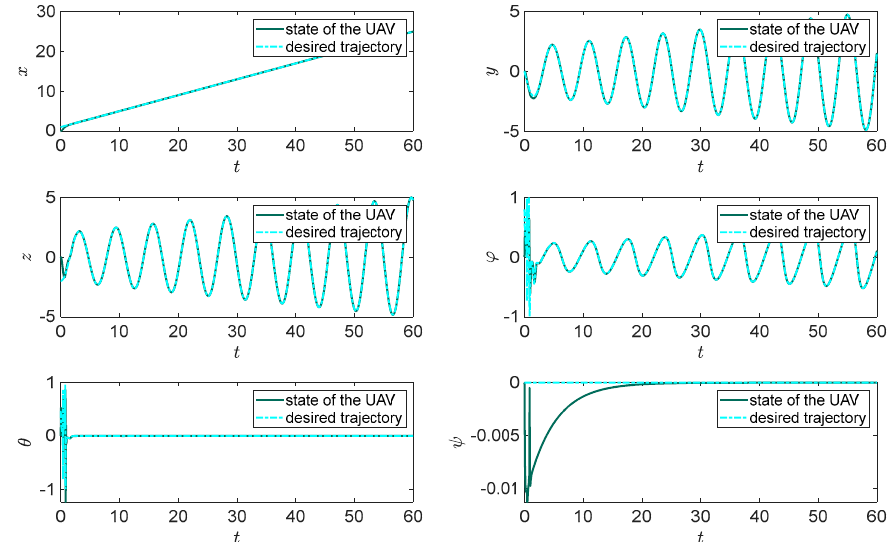
Figure 5. Time history of system states under proposed control technique.